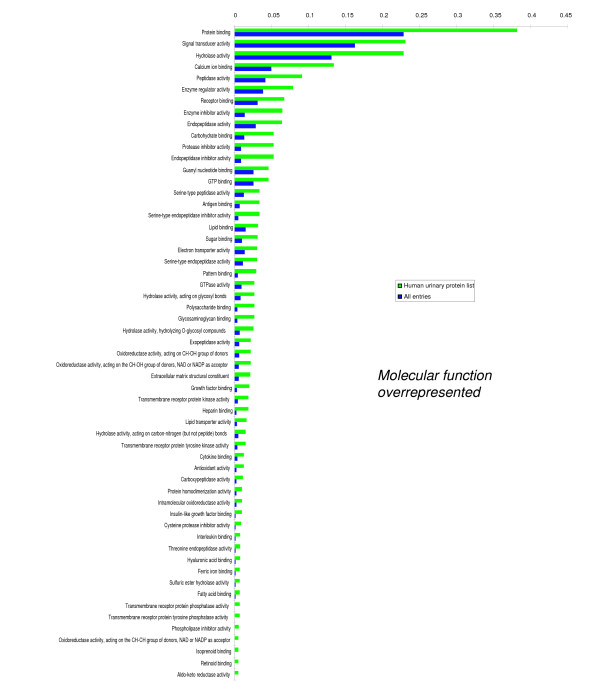
Significantly over-represented GO molecular function terms for the set of identified urinary proteins. Each term was selected as described in the legend for Figure 6. GO, Gene Ontology.